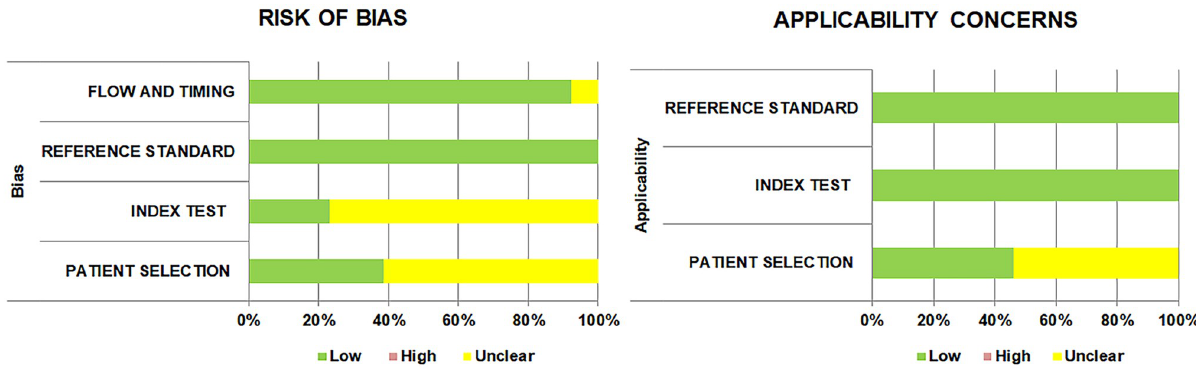
Fig 2. Quality assessment of the diagnostic accuracy studies-2